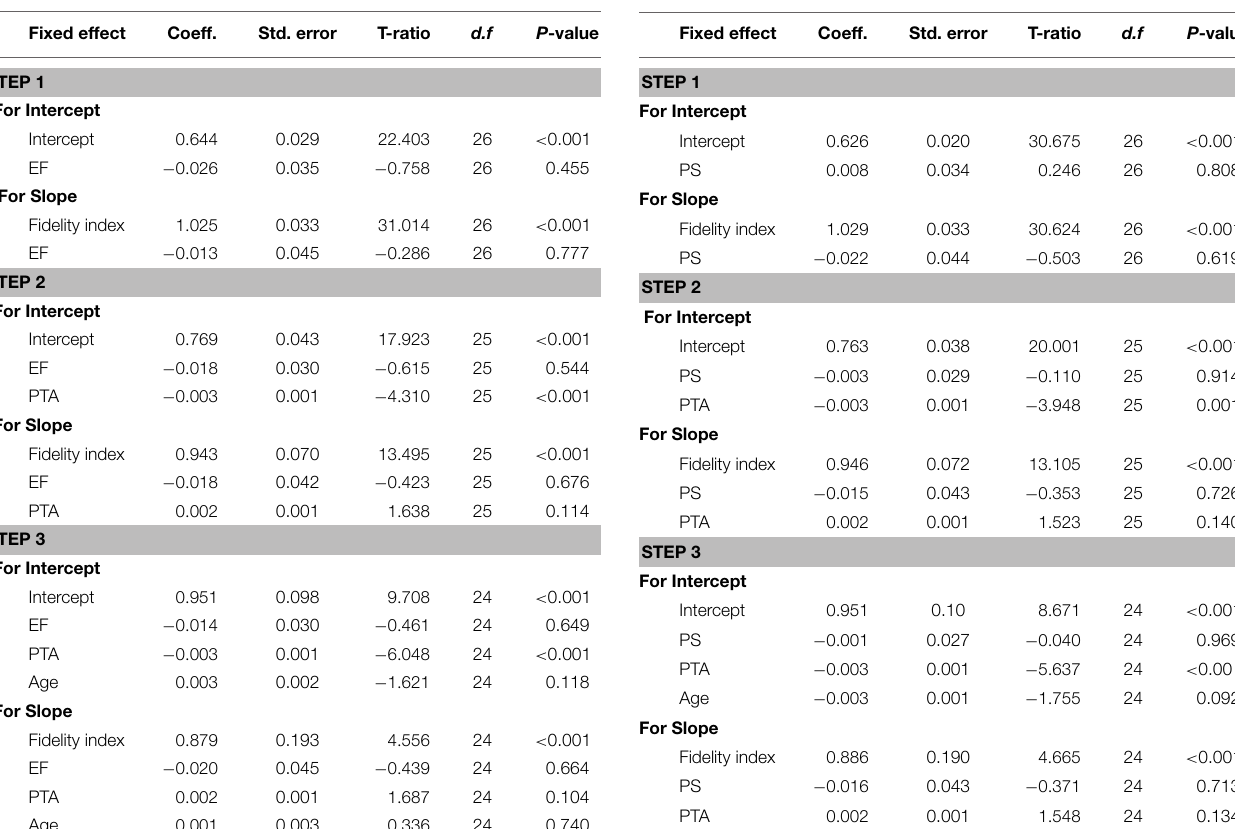
TABLE 4 | Summary of hierarchical linear model for intelligibility with processing speed (PS) as a predictor.